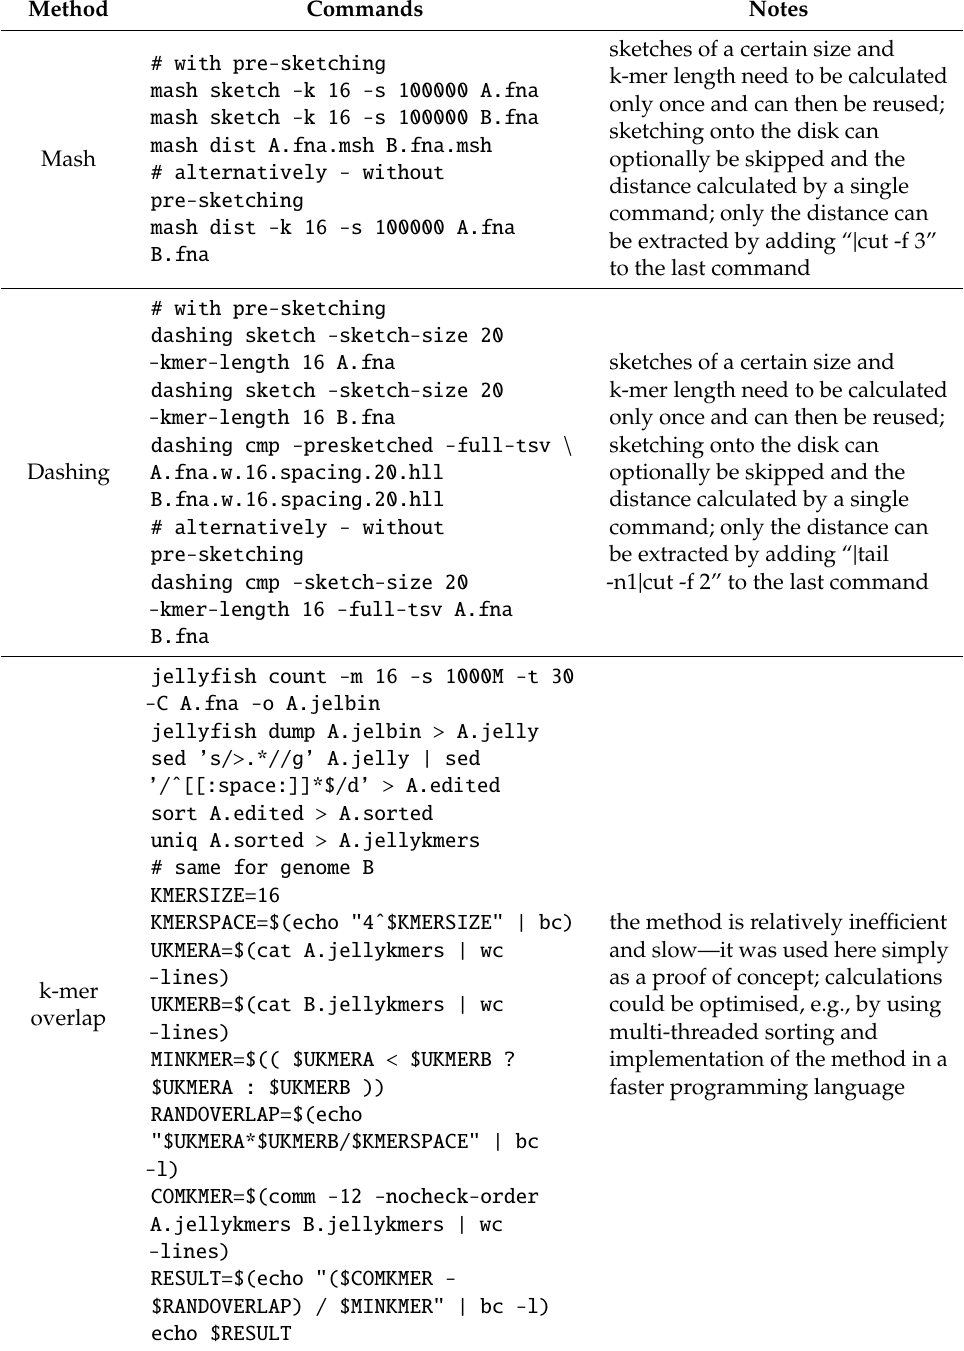
Table 1. Methods of genomic distance calculation between nucleotide genome assemblies in files A.fna and B.fna with the k-mer size